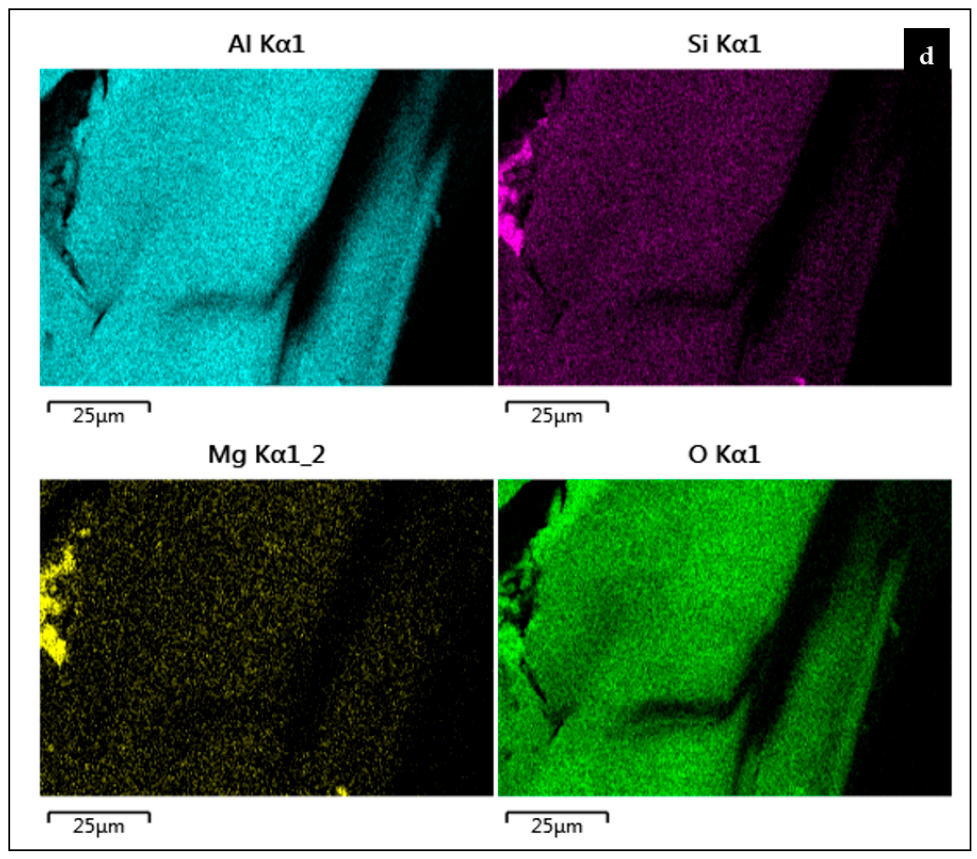
Figure 5. FESEM images taken from the substrate ( a ) and washcoated monoliths ( b ) and position of EDS area and ( d ) is the EDS mapping image of coated monolith ( c